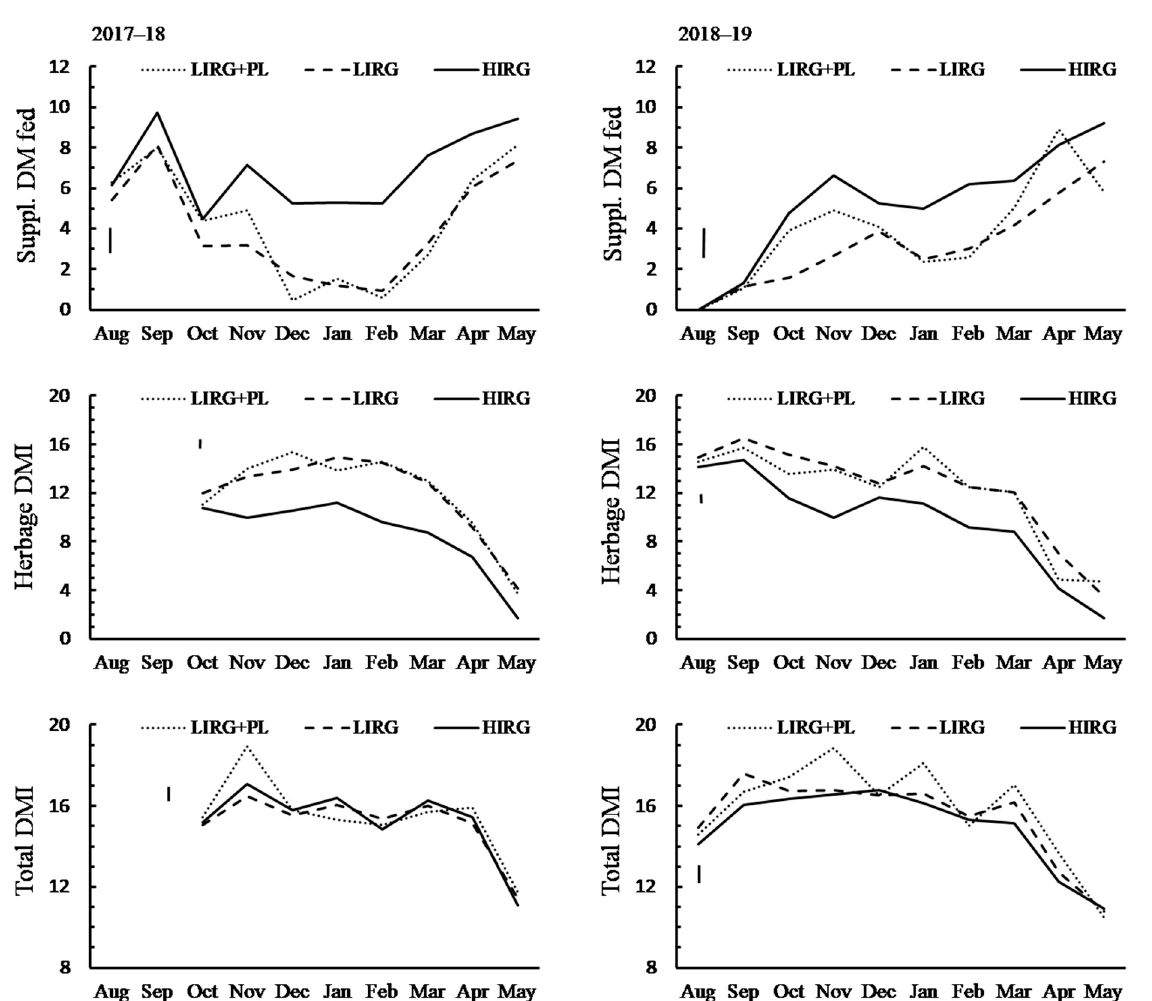
Figure 2. Estimated daily dry matter intake (DMI; kg/cow) of herbage (calculated based on individual cow energy output), supplement fed (mixture of maize silage and lucerne silage or grass silage), and total DMI (herbage + supplement; assuming supplement utilisation of 100%) of dairy cows grazing ryegrass and plantain-based swards in a lower input system (3.5 cow/ha stocking rate and 150 kg nitrogen/ha/year; LIRG + PL), perennial ryegrass–white clover mix sward in a lower input system (3.5 cow/ha and 150 kg nitrogen/ha/year; LIRG), or perennial ryegrass–white clover mix sward in a higher input system (5 cow/ha and 300 kg nitrogen/ha/year; HIRG) collected over two milking years, 2017/18 and 2018/19. Bars indicate LSD for farmlet effect within months.